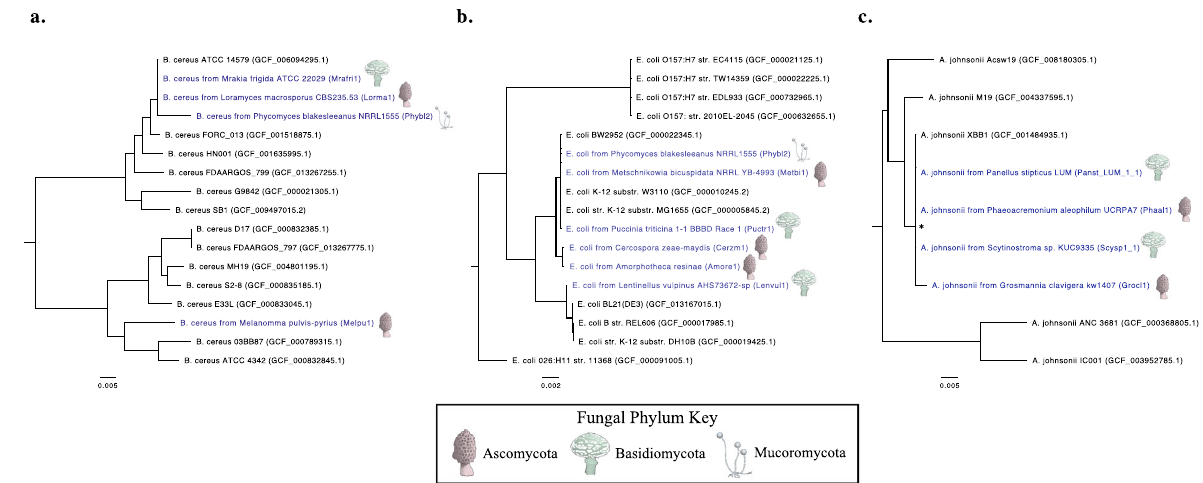
Fig. 7 Genome-wide single nucleotide polymorphism (SNP)-based phylogenetic analysis of fungal-derived bacterial sequences. Phylogenetic trees generated by analysis with PhaME for fungal-derived sequences of a Bacillus cereus , b Escherichia coli , and c Acinetobacter johnsonii . Fungal-derived sequences are annotated in blue lettering and include the corresponding JGI project ID (shown in parentheses) and icons next to their annotation indicate the phylum of the fungal host. Non-fungal-derived reference genomes are indicated in black. NCBI accession IDs are included for these reference genomes (shown in parenthesis). Branches with bootstrap values (1000 bootstrap replicates) <60% are marked with an asterisk (*). All trees are midpoint